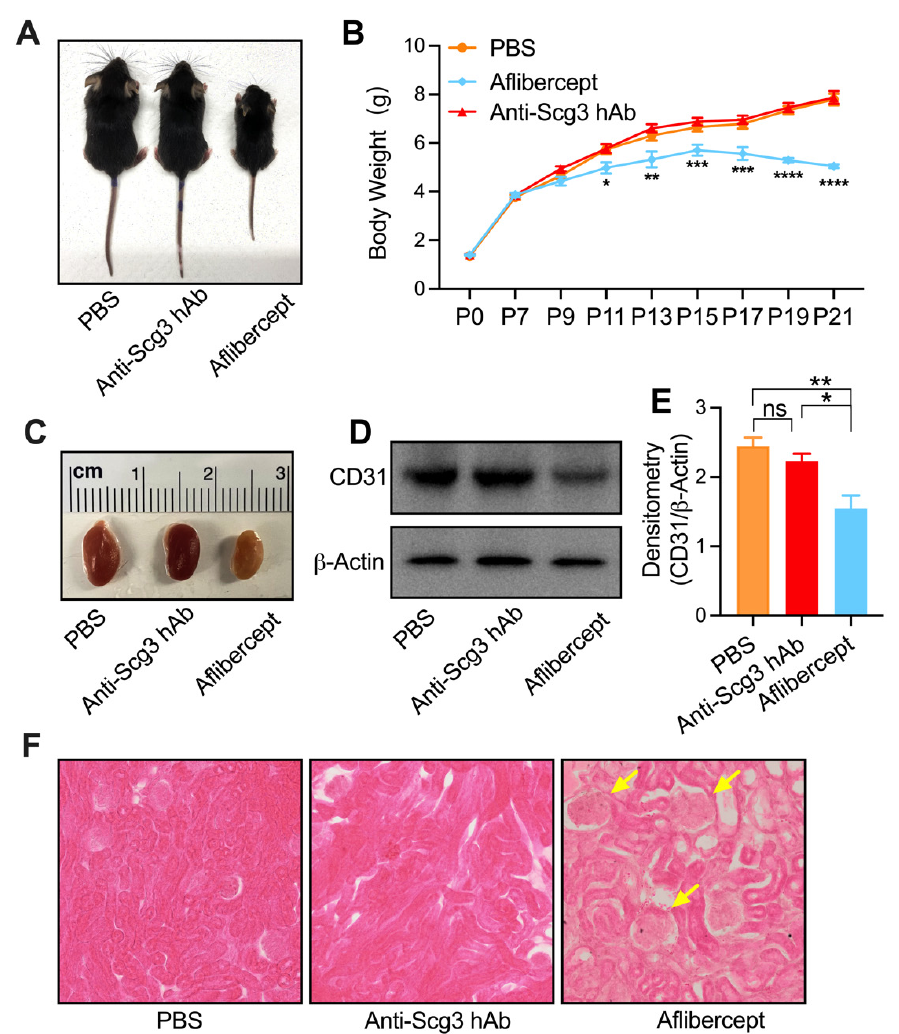
Figure 6. Systemic treatment with anti-Scg3 hAb was without adverse effects on the development of healthy neonatal mice. ( A ) Representative images of body size at P21 for healthy mice treated with PBS, anti-Scg3 hAb or aflibercept (i.p. treatment as in Figure 5A). ( B ) Quantification of the body weight of the mice in A. Aflibercept hinders the body weight gain. n = 9 mice (PBS), 10 mice (aflibercept), and 9 mice (anti-Scg3 hAb) for each group. ( C ) Representative images of kidney size at P21 for mice treated with PBS, anti-Scg3 hAb, or aflibercept (i.p. treatment as in Figure 5A). ( D ) Western blot analysis of kidneys in ( C ) using anti-CD31 antibody (endothelial cell marker). Aflibercept reduced kidney endothelial cells. ( E ) Quantification of CD31 signal intensity in ( D ). Data were normalized against β -actin. n = 4 kidneys in 4 mice/group. ( F ) Representative image of kidney H&E staining. Arrows indicate aberrant glomerular morphology in the aflibercept group. Mean ± SEM. * p < 0.05, ** p < 0.01, *** p < 0.001, **** p < 0.0001; ns, not significant; one-way ANOVA